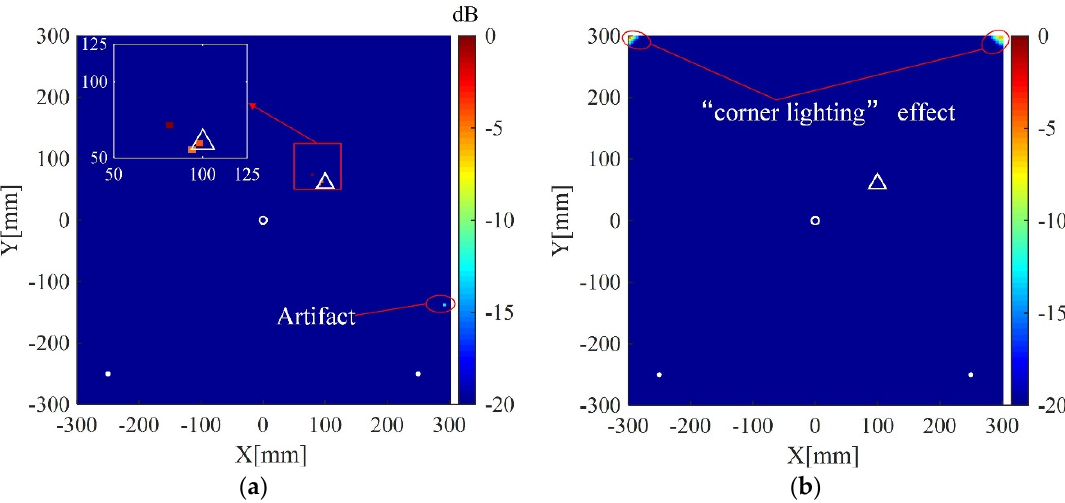
 ‐ norm optimization can lead to a sparse solution. 1